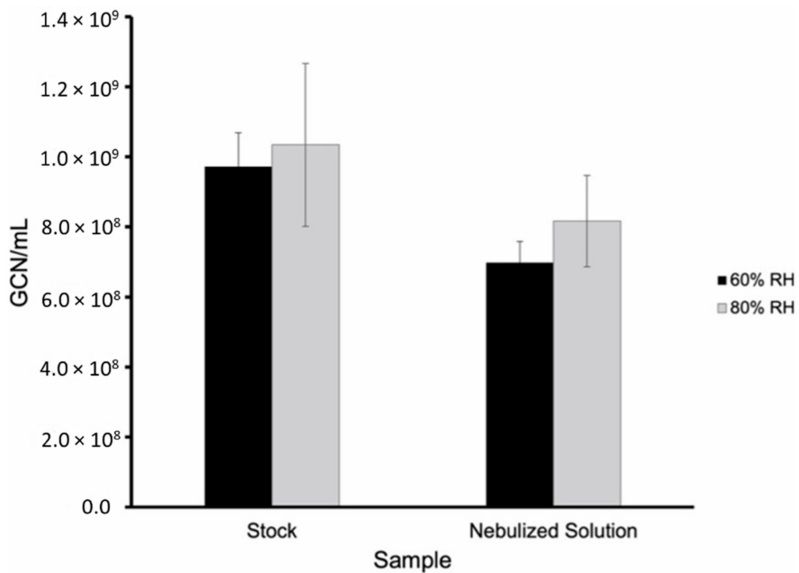
Figure 6. GCN/mL BcoV at 25 ◦ C and 60% and 80% relative humidity of the stock and nebulized solution samples (Table S2 in Supplementary Material).